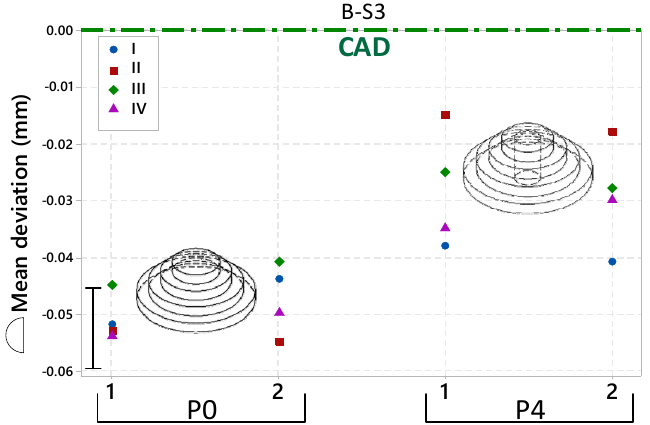
Figure A1. Three-dimensional (3D) profile mean deviations of the Shape B artifact having the biggest size (S3); Scan I (as-built); Scan II, after stress relief; Scan III, after part removal; and Scan IV, after shot peening .